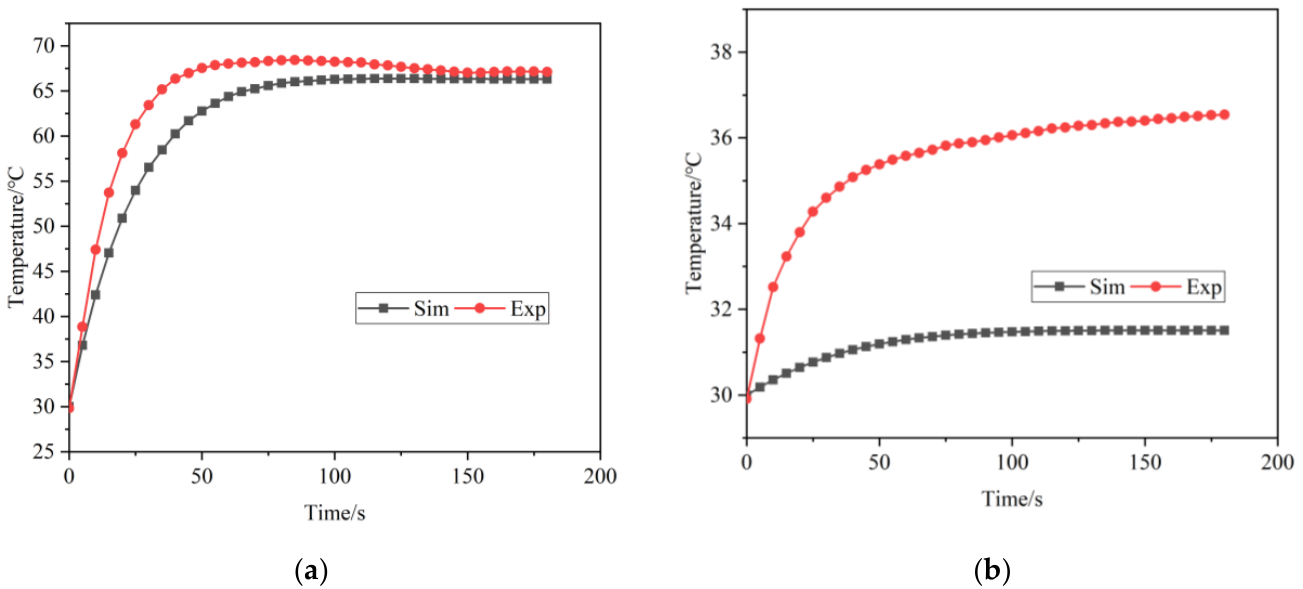
Figure 8. The temperature rise curves of the thin film. ( a ) The antinode area of the electric field; ( b ) The node area of the electric field.